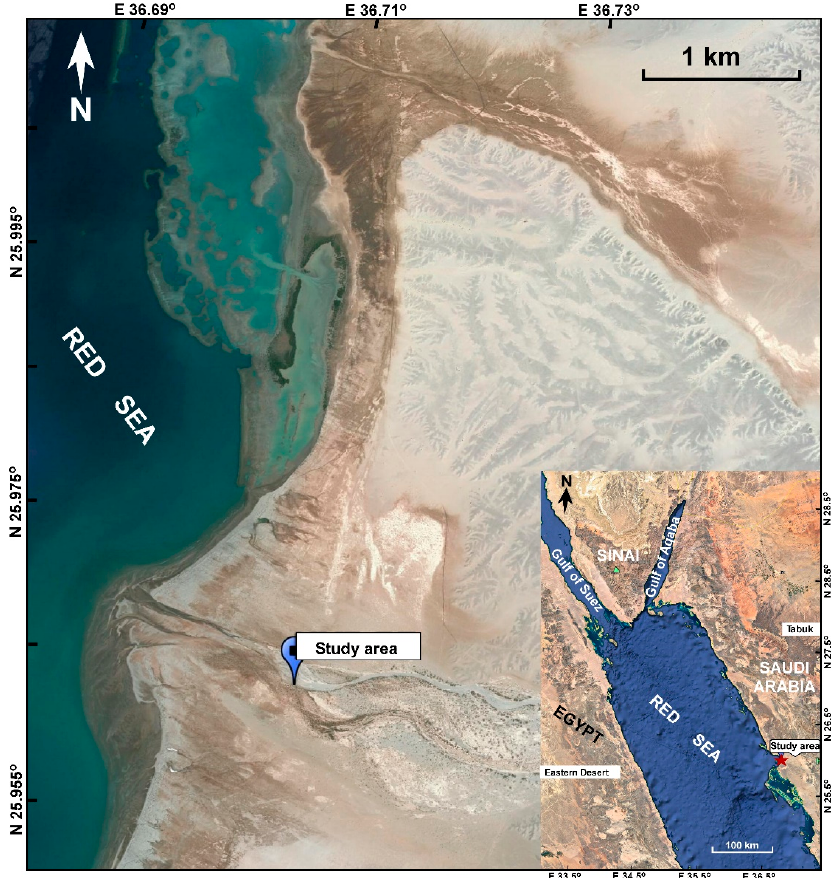
Figure 1. Landsat image shows the area of study and the location of the beachrock exposure at the mouth of Wadi Al-Hamd